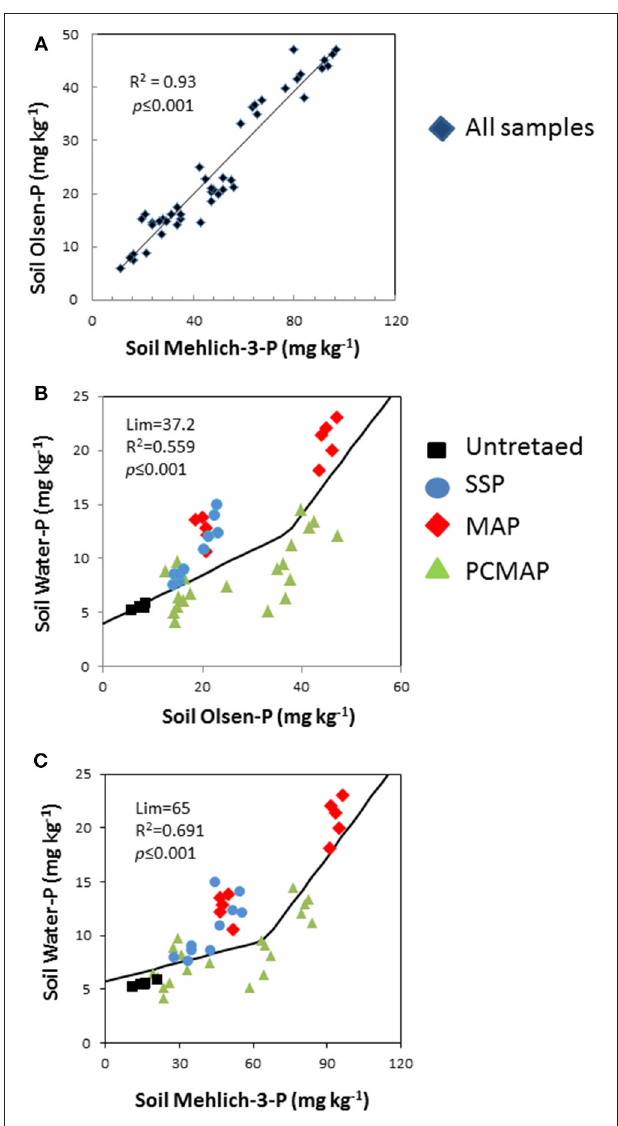
FIGURE 3 | (A–C) Relationship among soil Mehlich-3 P, Olsen P, and water P concentrations after 45 days application of treatment. In the graph split-line model fitted Equation (1). To appreciate the effect of the treatment on the model, the cases were differently colored: untreated, black squares; single superphosphate, SSP, blue circles; mono-ammonium phosphate, MAP, red rhombuses; polymer-coated mono-ammonium phosphate, PCMAP, green